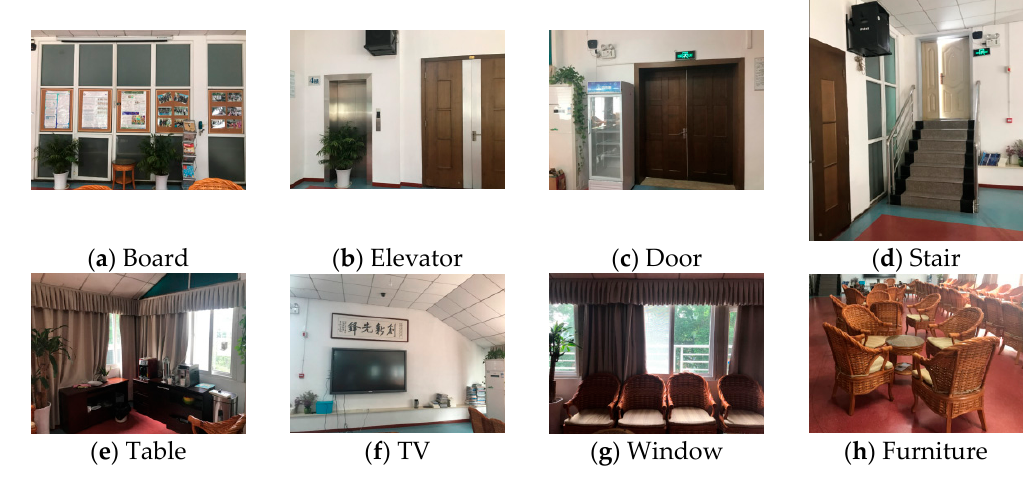
Figure 3 . ( a )–( h ) Exemplar images for each class. Figure 3. ( a – h ) Exemplar images for each